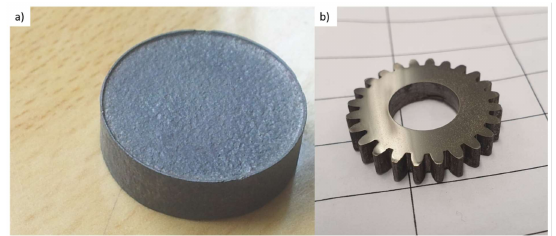
Figure 7. Manufactured samples ( a ) disc and ( b ) gear wheel.